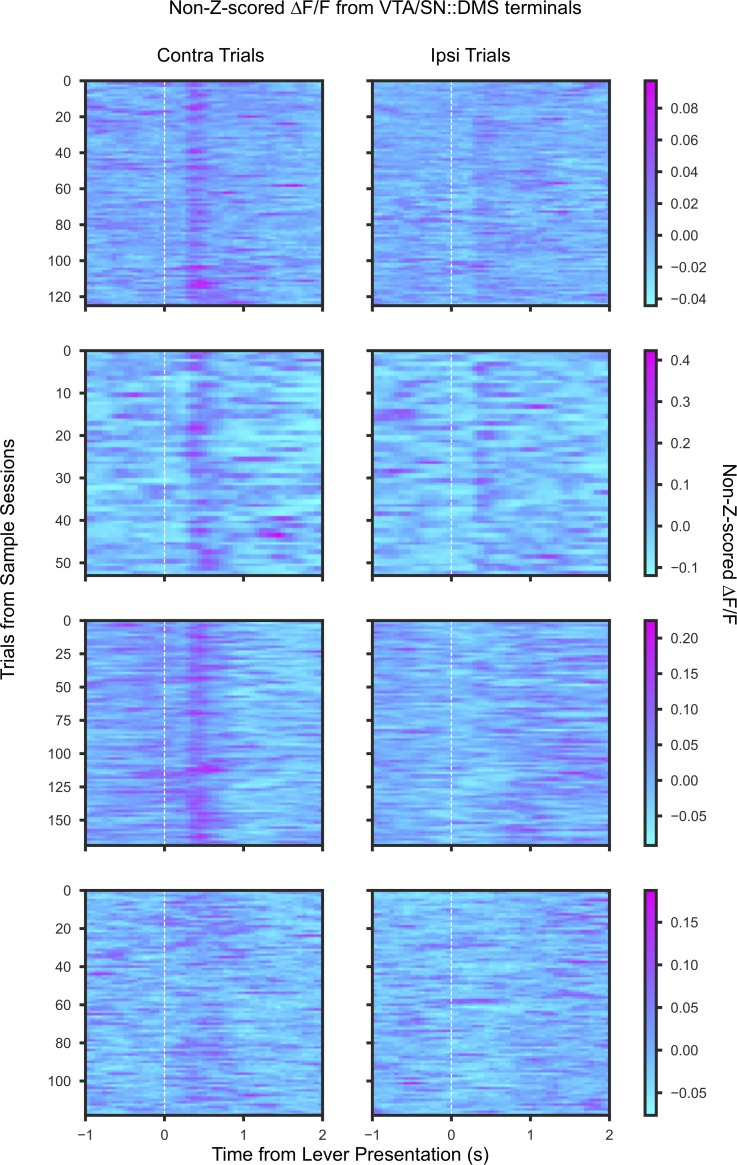
Four Examples of non-Z-scored Individual Sessions of Photometry Data from VTA/SN::DMS Terminals.Sample, not Z-scored ∆F/F recording from VTA/SN::DMS Terminal. Each row is an example session from a different mouse. Traces are time-locked to the lever presentation for contralateral trials (left column) and ipsilateral trials (right column). White dotted vertical line indicate lever presentation. Colorbars are provided for each row for each example session.